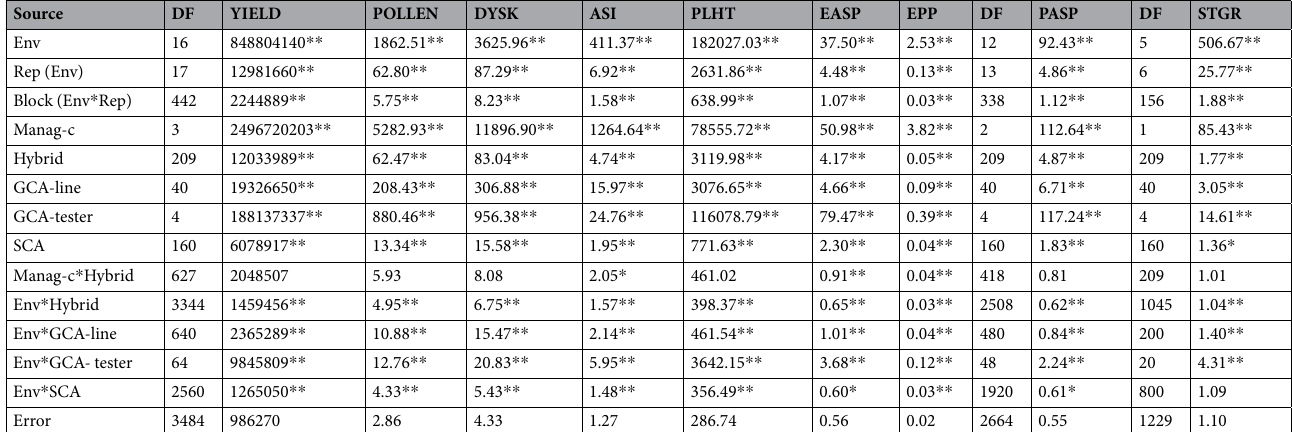
Table 3. Mean squares of different traits of early maturing yellow maize hybrids across four management conditions in 2015 and 2016. * , ** Significant at 0.05 and 0.01 probability levels, respectively; Env = environment; Rep = replication; Manag-c = management condition; YIELD = Grain yield (kg ha − 1 ); Pollen = days to 50% anthesis; DYSK = days to 50% silking; ASI = anthesis-silking interval; PLHT = plant height (cm); PASP = plant aspect; EASP = ear aspect; EPP = ears per plant; STGR = stay-green